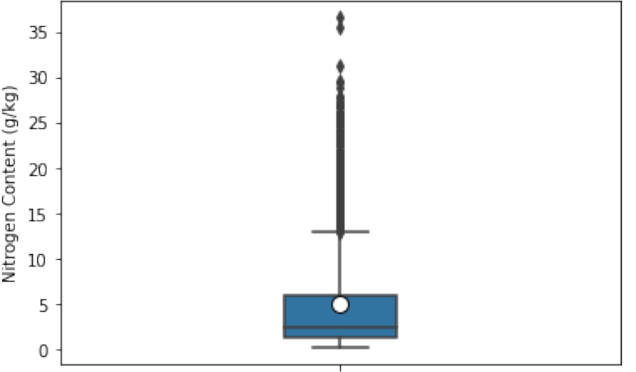
Figure 6. Box-plot of nitrogen content interquartile range, mean, skewness, and outliers.